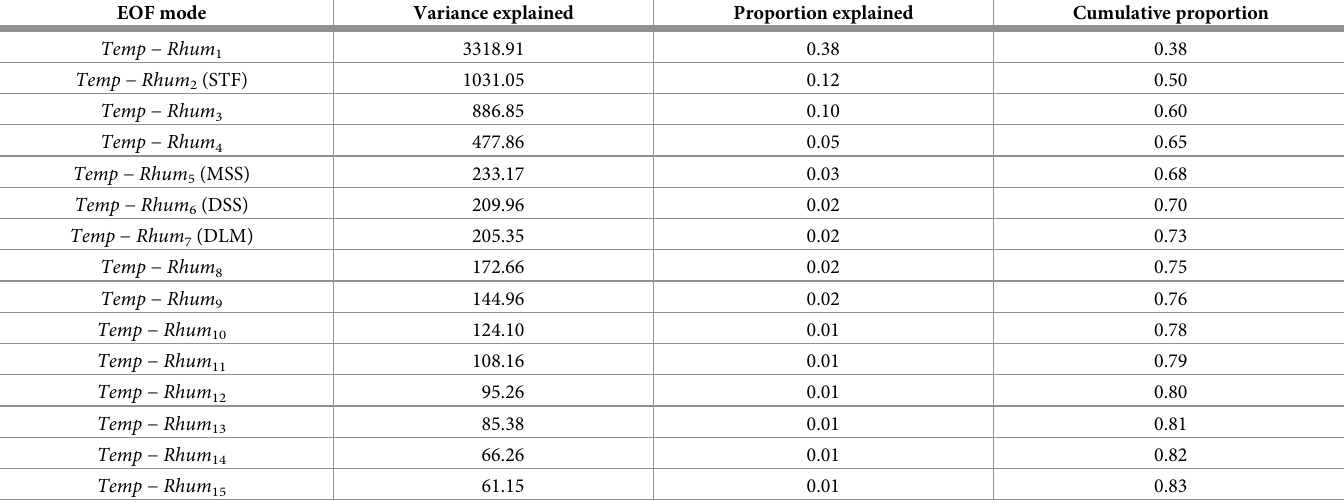
Table 2. Summary of the explained variance, proportion of variability explained by each temperature and relative humidity mode as well as the cumulative propor- tions. The Temp − Rhum i is the i th EOF mode of the air temperature and relative humidity group.